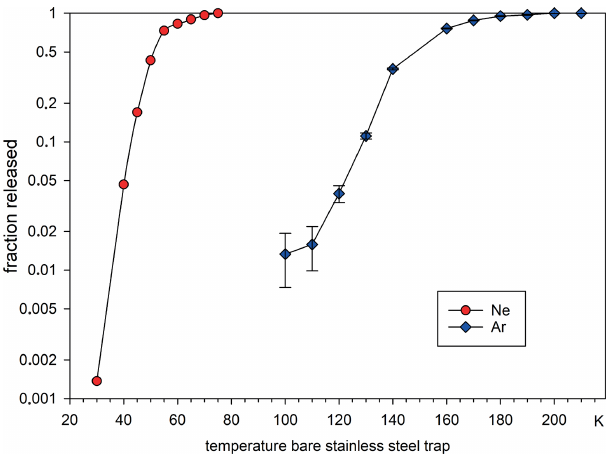
Figure 2. Desorption curves of Ne and Ar on the stainless-steel cold trap measured with the Hiden quadrupole. The uncertainties of the argon determinations at low fractions released are due to a significant Ar background of the quadrupole (e.g. measurement at 100K was just 5% higher than the